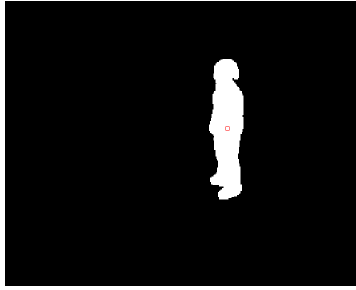
Figure 3. Example image of the human silhouette with centroid.